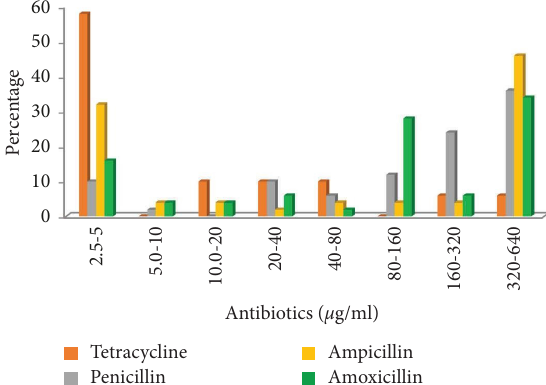
Figure 2: MIC range of antibiotics in P. vulgaris ( n � 50) from entire sampling sites of hospital wastewater.